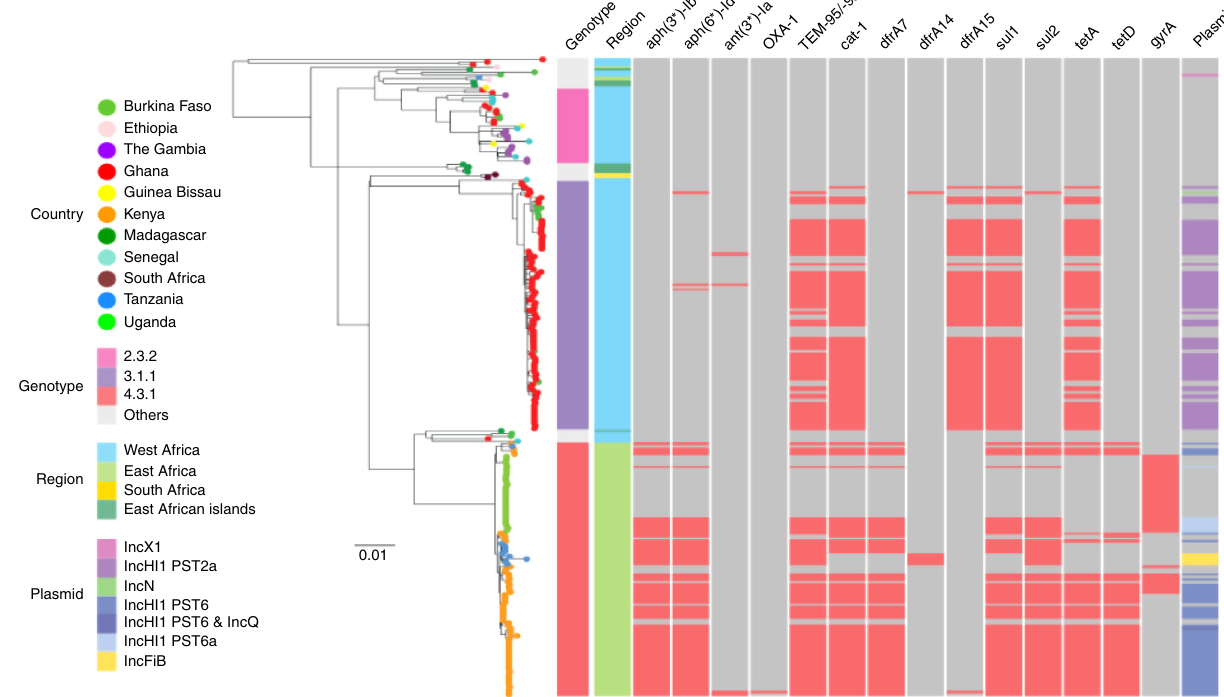
Fig. 4 The antimicrobial gene distribution within sub-Saharan African Salmonella Typhi. Maximum likelihood phylogenetic tree of 249 S . Typhi isolates from this study with corresponding metadata including genotype, location, antimicrobial resistance genes (AMR), and plasmids (see keys). Countries where S . Typhi isolates were isolated are highlighted by coloured circles at the tip of the branches. The three major genotypes and sub-regions of the Africa continent are shown by the coloured bars; present AMR genes are shown in red. The scale bar indicates the number of substitutions per variable